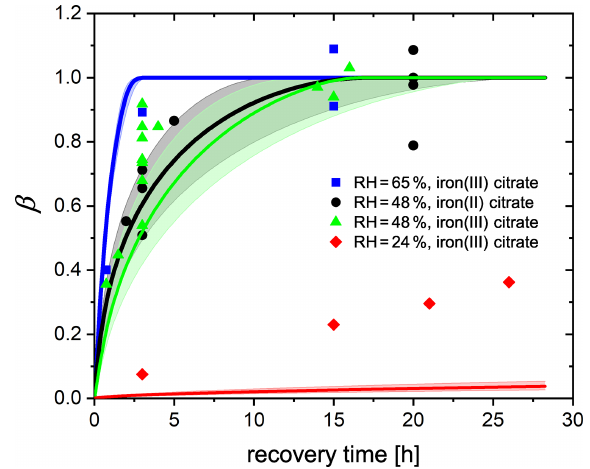
Figure 11. Fe III fraction after different time intervals of recovery in O 2 from EDB observations. Fe III ( Cit )/ CA (molar ratio of 0.05) particles at 293.5K with 24% RH (red diamonds), 48% RH (green triangles), and 65% RH (blue squares). Black dots: experiments with Fe II ( HCit )/ CA particles at 48% RH. Lines: red (24% RH), black (48% RH), and blue (65% RH) are the Fe III fractions pre- dicted using the PRAD model; the shaded areas indicate model out- put assuming ± 2% RH uncertainty in the EDB experimental con-